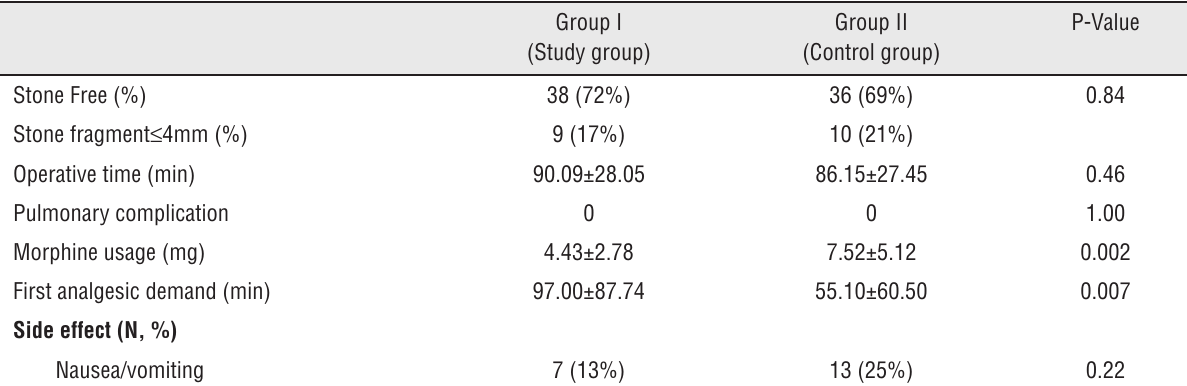
Table 2 - clinical outcomes and complications (Total